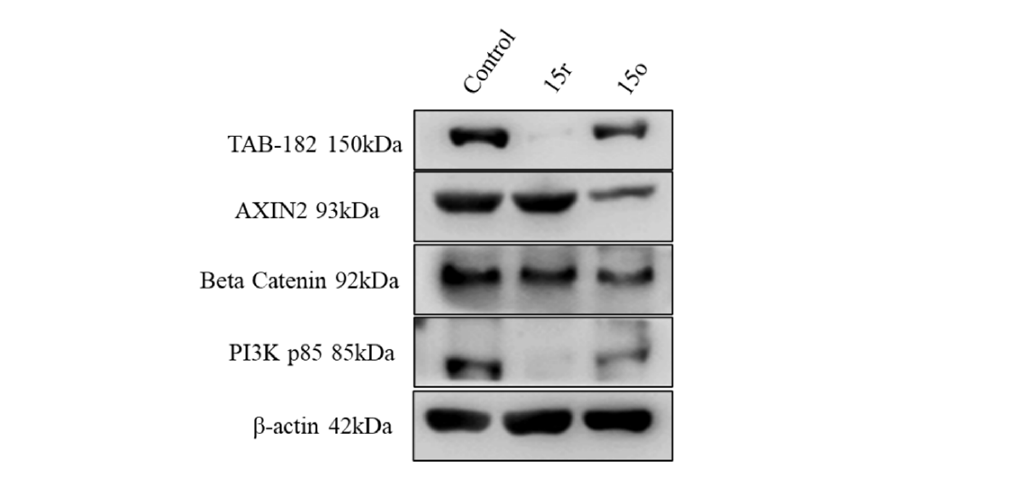
Table 2. Docking scores of all synthesised compounds ( 15a–r ) in the catalytic binding pocket of tankyrase and PI3K receptor in colorectal cancer (PDB IDs: 4OA7 and 3L54).